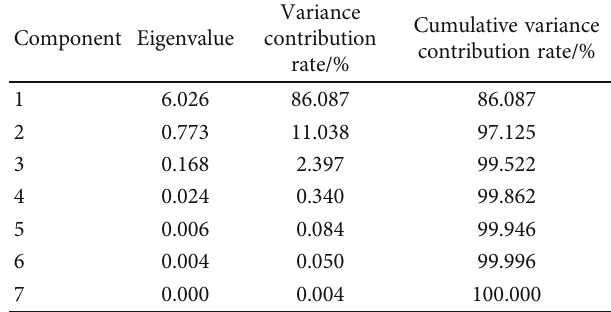
Table 2: Results of